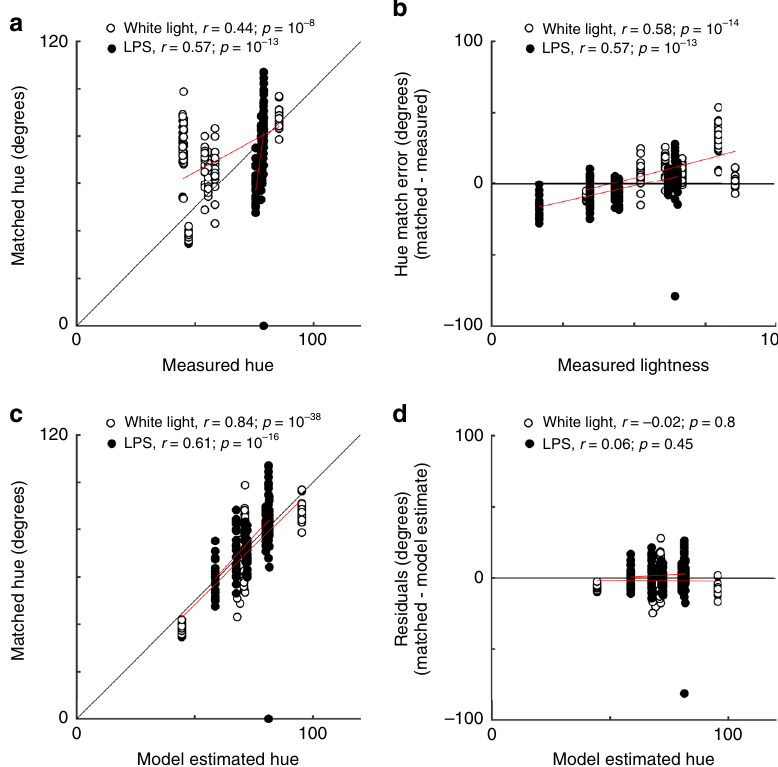
Fig. 3 Estimating the impact of lightness and chroma on hue matching using matches to non-color-diagnostic objects. a Participants ’ ( N = 20) hue matches versus the measured hues for non-color-diagnostic stimuli (toys, masked forehead; CIE a * b * angle). Markers show results of matches made under white light (open symbols) and LPS light (solid symbols). b The difference between the angle of the matched hue and the measured hue versus measured lightness (white light, r = 0.58; LPS, r = 0.57). c Matched hue versus the estimated hue from the multivariate linear regression model. The model fi t matched hue as predicted by measured hue, lightness, and chroma, for the non-color-diagnostic objects (white light, r = 0.84; LPS, r = 0.61). d Residuals of the model fi t (matched — estimated) as a function of estimated hue (white light, r = − 0.02; LPS, r = 0.06). Source data are provided as a Source Data fi